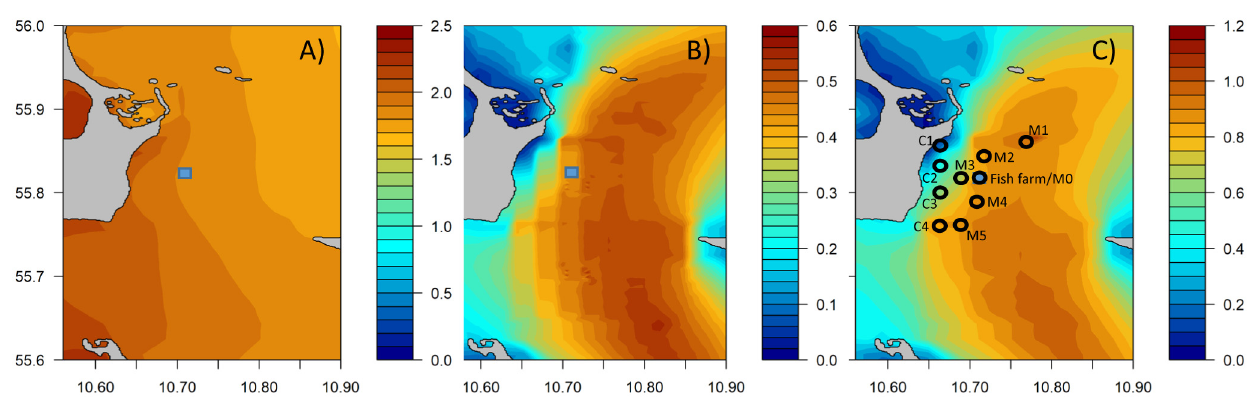
Fig. 4. Average surface (A) chl a concentration (mg m −3 ), (B) current velocity (m s −1 ) and (C) food flux (mg m −2 s −1 ) from July to November 2009. The blue box marks the location of the fish farm and the black circles show the locations of potential mussel farms (C: coastal, M: open